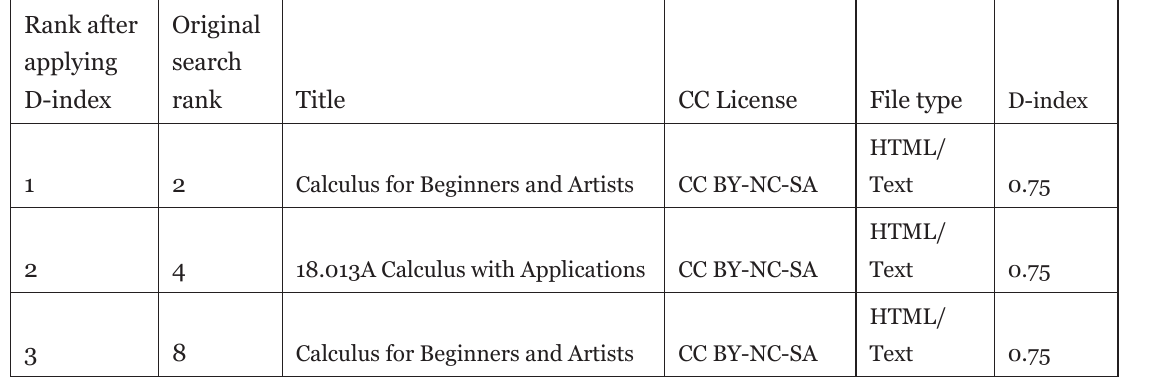
Top Ten Results when D-index is Applied to the Results Returned by MERLOT Rank after